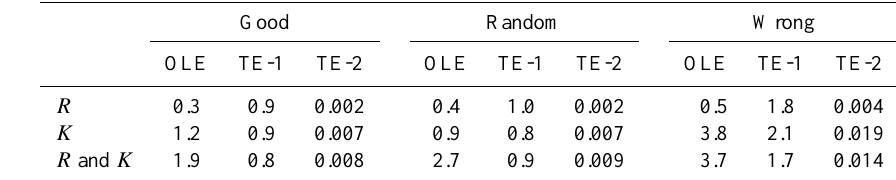
Table 4. Normalized root mean square error for the assimilation period.